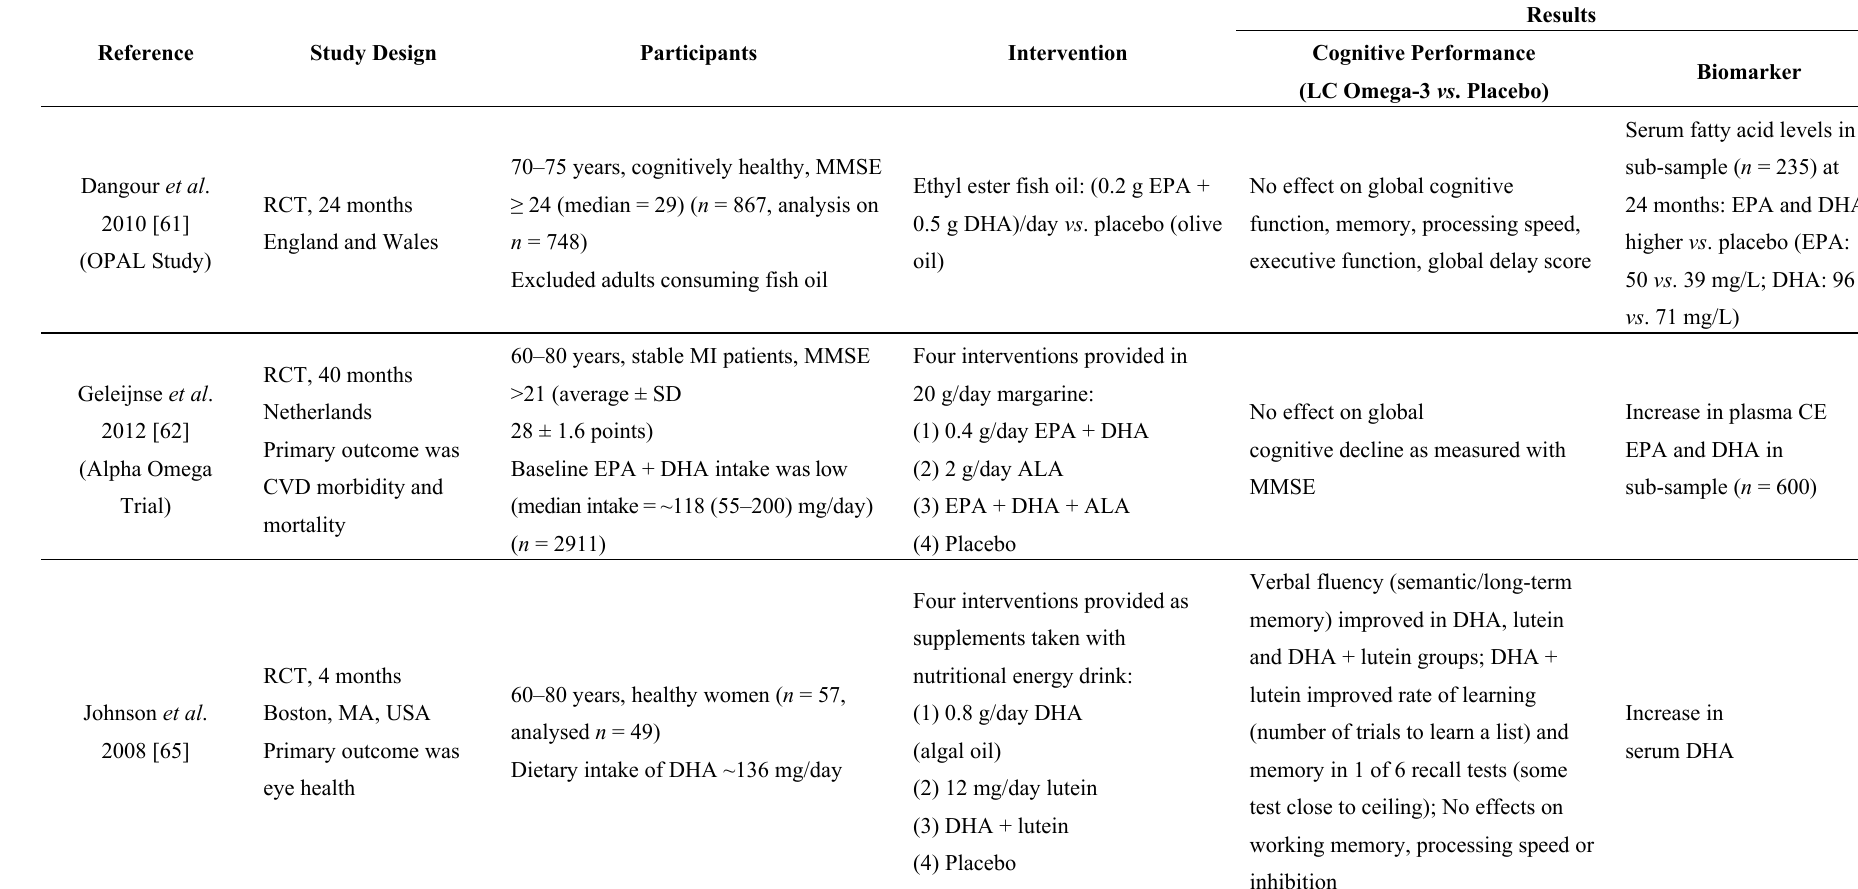
Table 3. Nutrition intervention trials of long-chain omega-3 PUFA and cognitive function in older